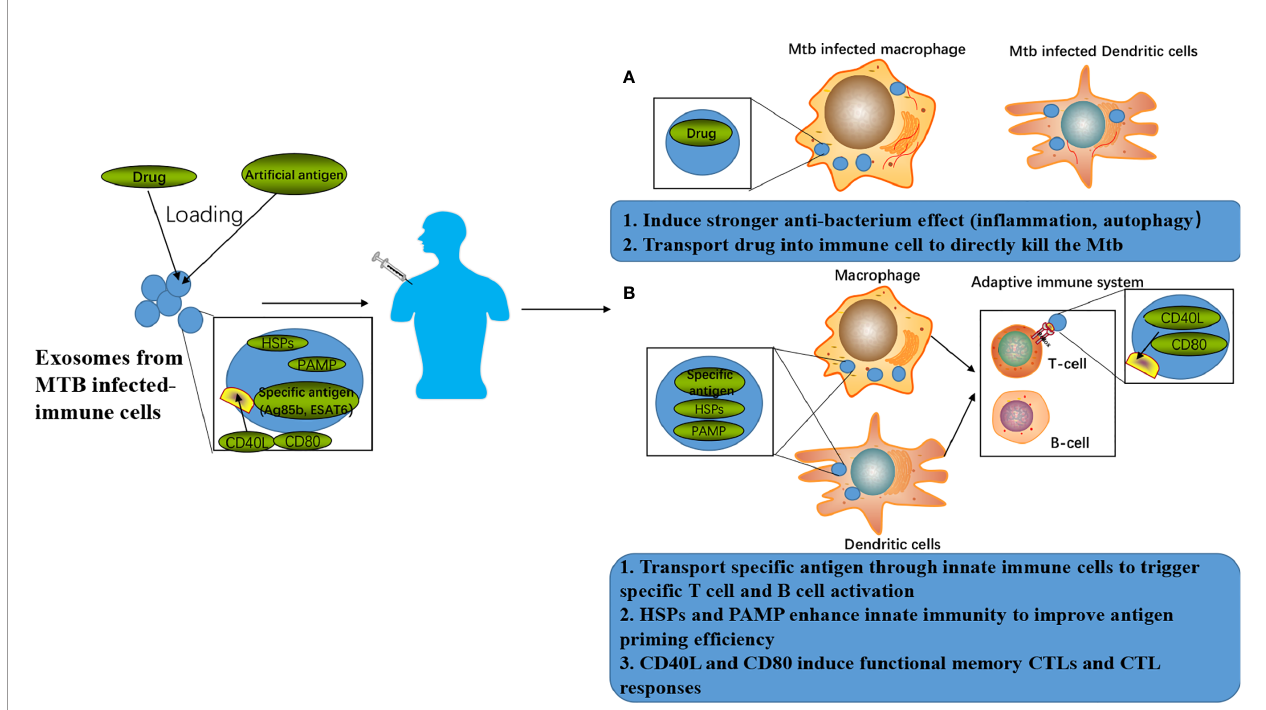
FIGURE 2 | Exosomes-associated anti-TB strategies. (A) Exosomes can be loaded with drugs to achieve enhanced anti-TB therapy by combining the improved killing ef fi ciency induced by the drugs and anti-TB responses induced by the exosomes. (B) Exosomes can be loaded with speci fi c antigens to achieve enhanced anti-TB immune responses by combing the T cell and B cell activation induced by the speci fi c antigen as well as anti-TB responses induced by the exosomes.